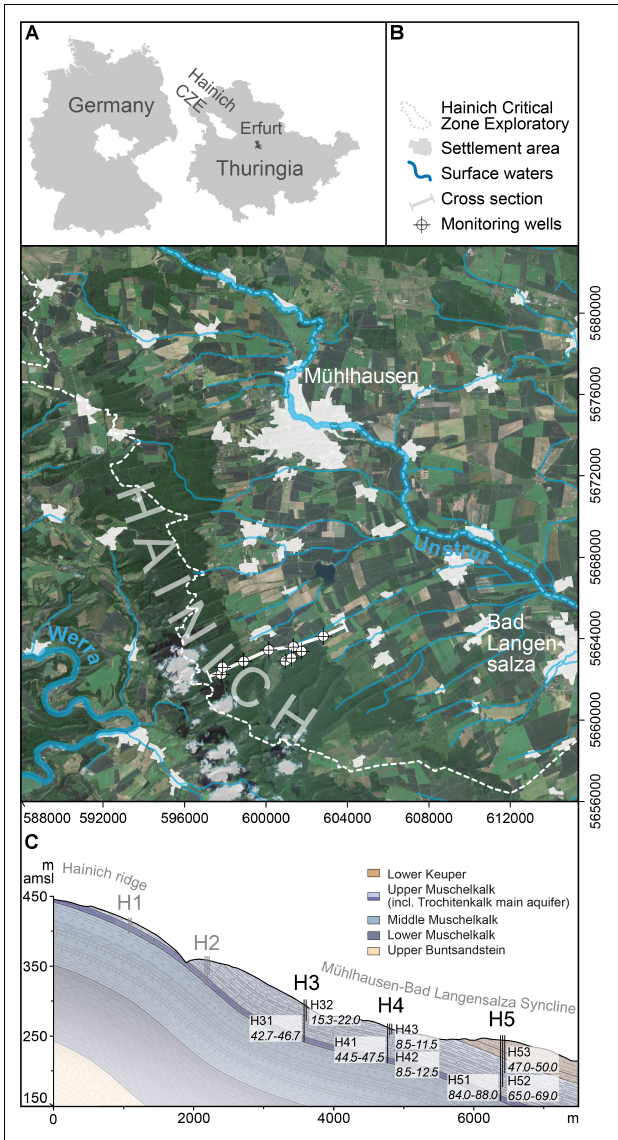
FIGURE 1 | (A,B) Location of the study site in Central Germany. (C) Schematic cross-section of the Hainich CZE multi-well groundwater transect showing the bedrock strata configuration and the screen sections in m below ground level (after Lazar et al., 2019). Data sources: DEM GDI-Th, DLM250 GeoBasis-DE/BKG 2016; dl652 d/by-2-0, http://govdata.de/dl-de/ by-2-0; satellite image: Copernicus Service information,